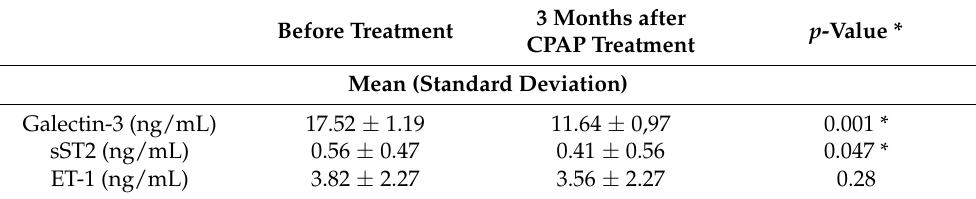
Table 5. Changes in blood serum biomarker concentrations after treatment. 3 Months after p -Value * Before Treatment CPAP Treatment Mean (Standard Deviation) Galectin-3 (ng/mL) 17.52 ±